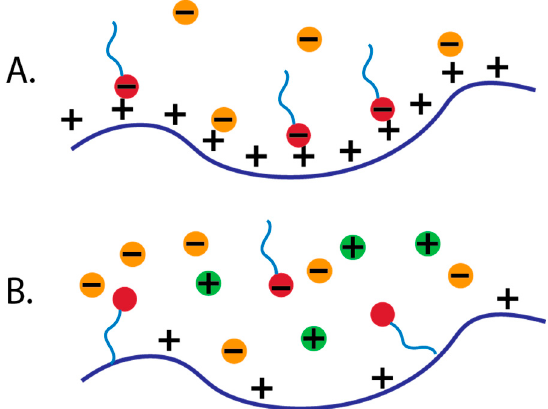
Figure 3. Depiction of binding of surfactant to polyelectrolyte chain. ( A ) without the presence of added salt ( B ) in the presence of added salt.